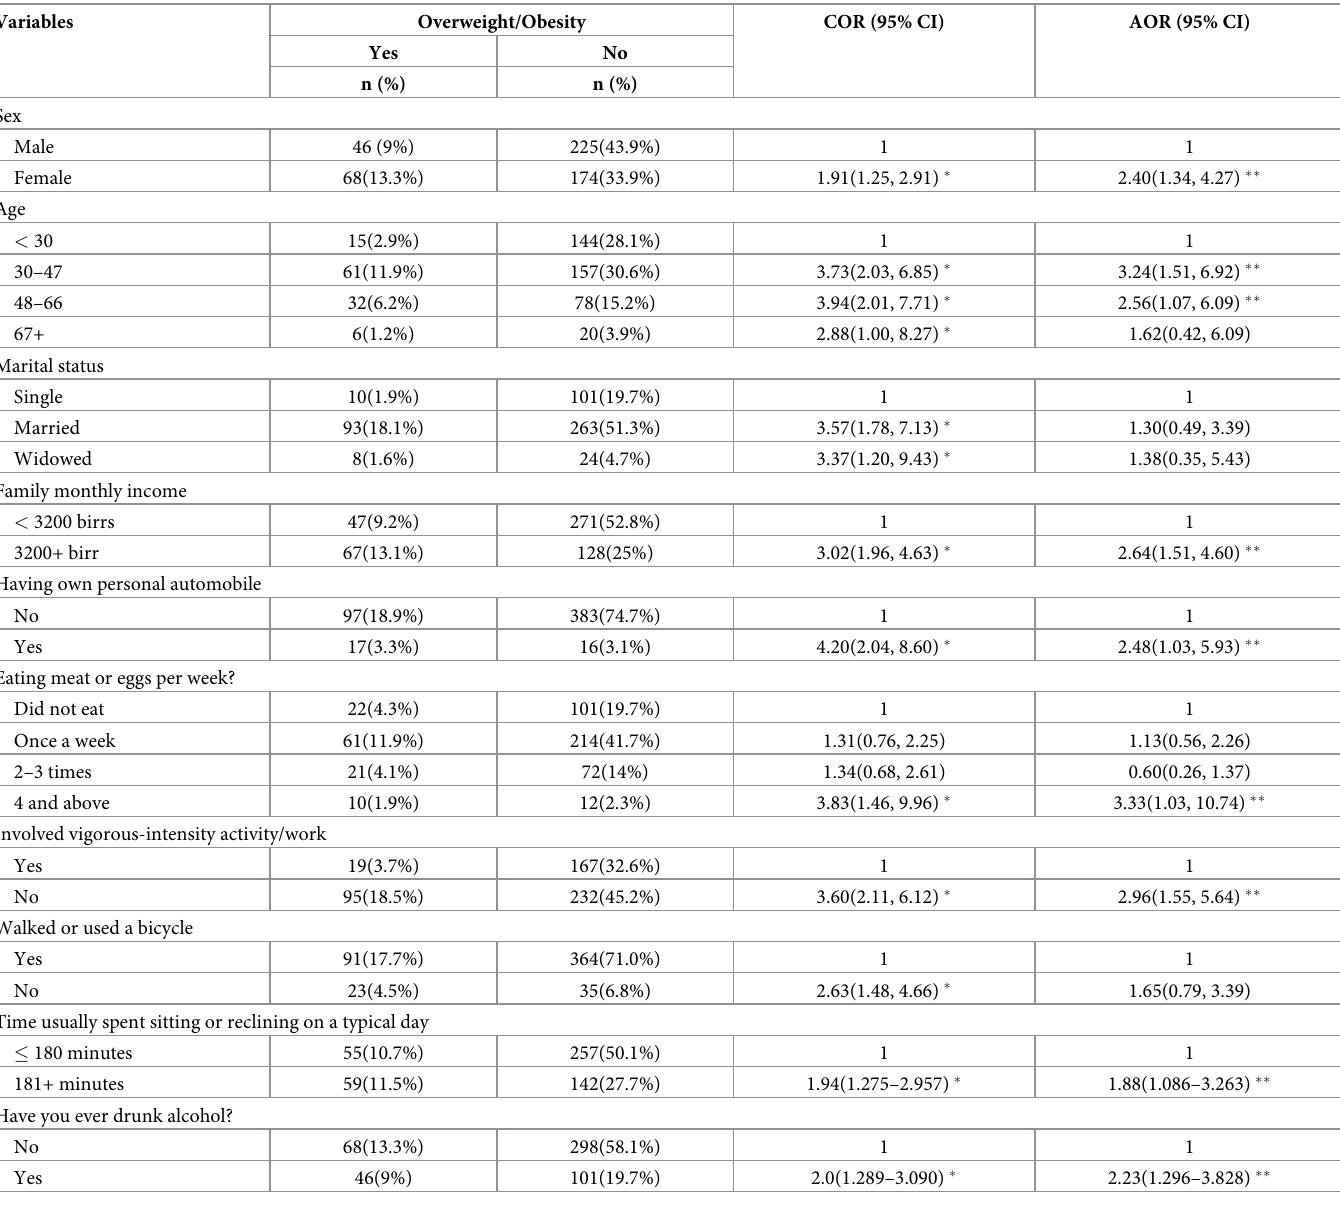
Table 6. Factors associated with overweight or obesity among adults in Welkite town, Southern Ethiopia, 2020, [n = 513].